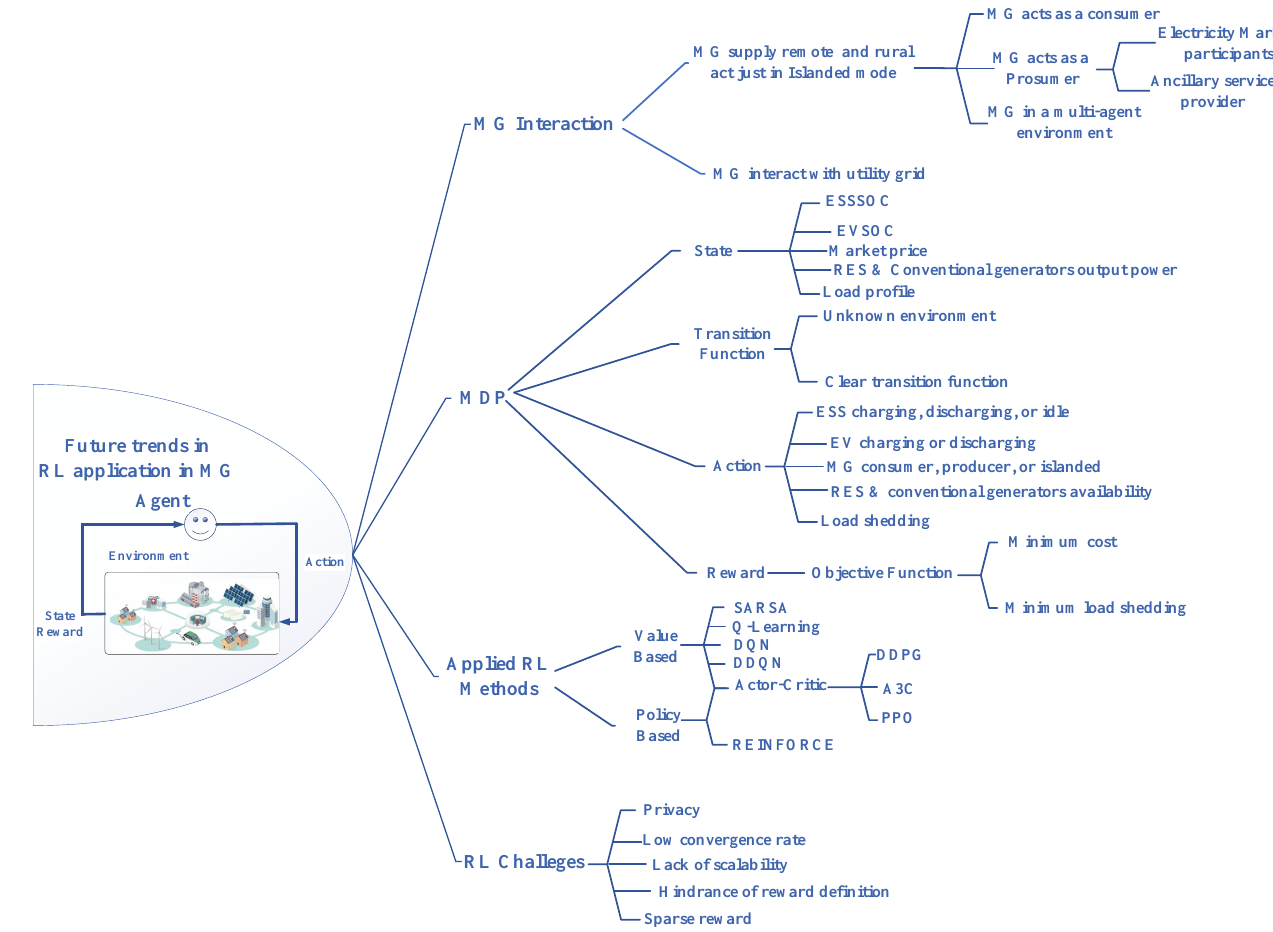
Figure 6. Future trends and requirements of MG scheduling as the utility grid service